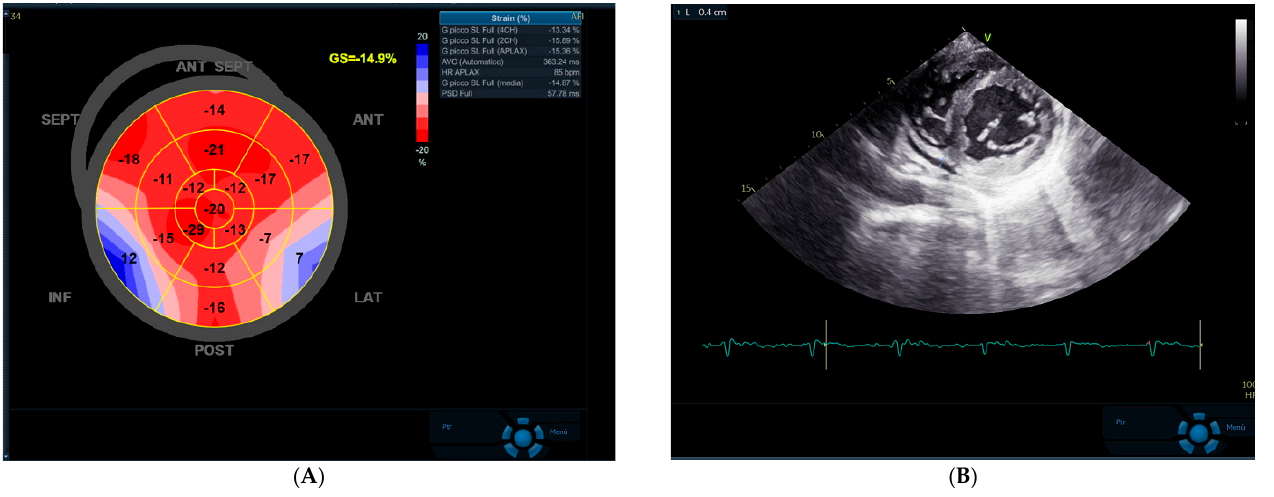
Figure 3. 2D-Echocardiogram showing small reduction in left ventricular global longitudinal strain ( A ) and mild, circumferential pericardial effusion ( B ).